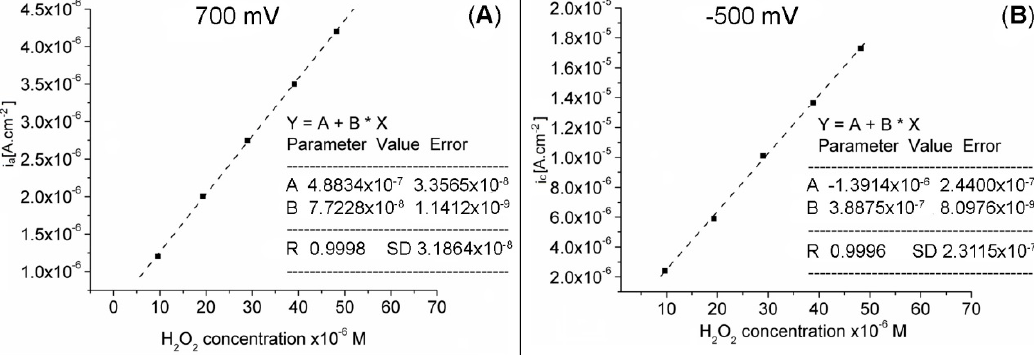
Figure 10. Linear dependence between ( A ) anodic current at 700 mV (R: 0.9998, SD: 3.1864 × 10 − 8 ) and ( B ) cathodic current at − 500 mV (R: 0.9996, SD: 2.3115 × 10 − 7 ) on the Pt-Porf-GCE and the concentration of hydrogen peroxide, in MES buffer solution, at 50 mV/s, 25 °C.